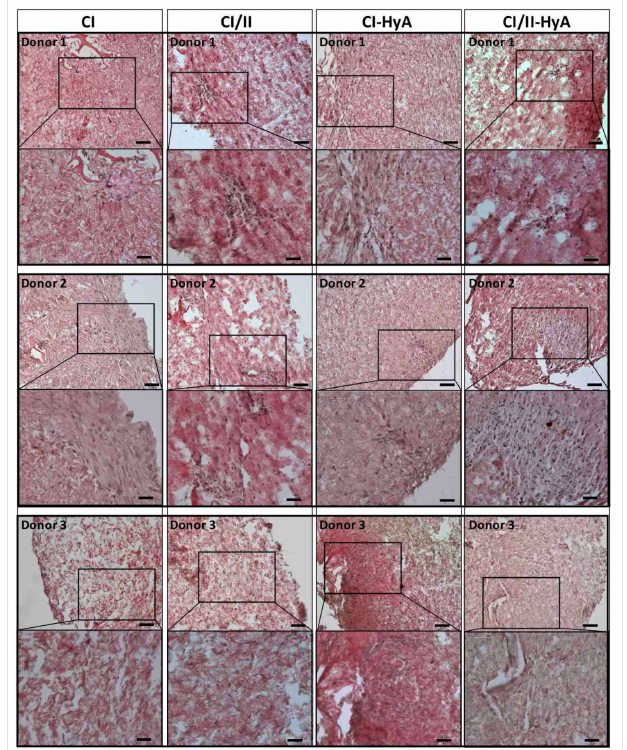
Figure 4. All collagen scaffolds demonstrated an equal capacity to sustain cellular infiltration and migration. Representative histological images of cell-seeded scaffolds stained with haematoxylin and eosin after 28 days in culture. Scale bar represents 100 µ m length ( top images) and 50 µ m length ( bottom images). Histological images were collected for scaffolds seeded with human MSCs from donor 1, 2 and 3, respectively.